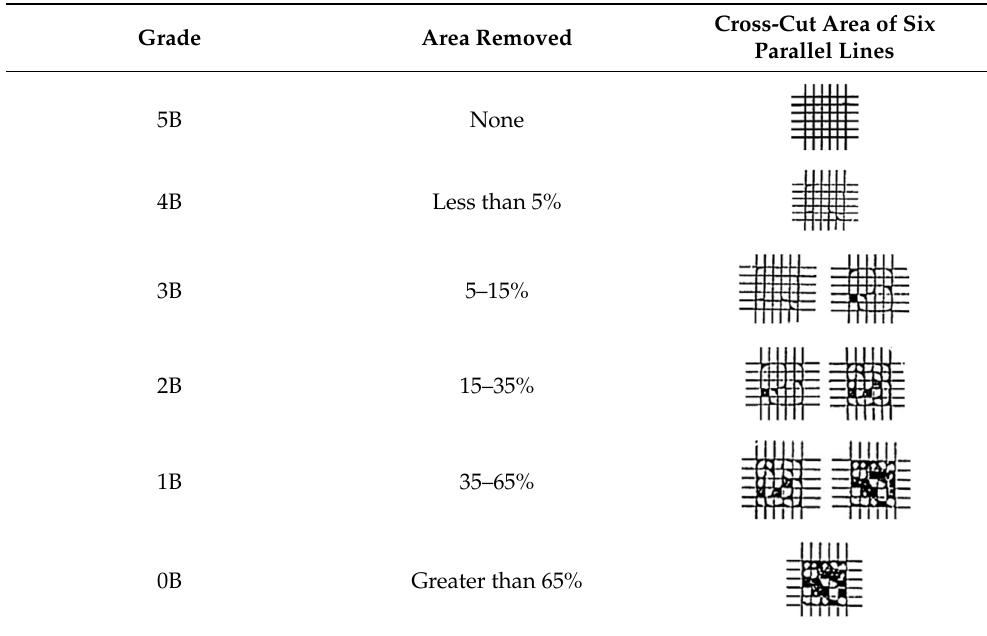
Figure 9. Coating adhesion test results. Table 4. Classification chart for paint adhesion tests [14].